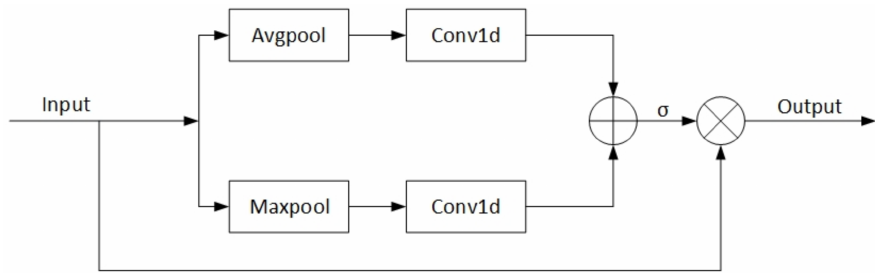
Figure 3. The IECA Module’s